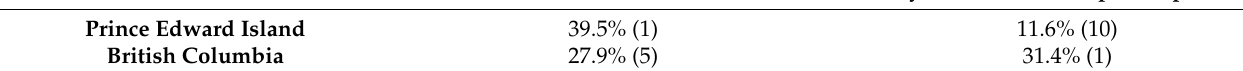
Table 1. Purchasing habits for produce per province.